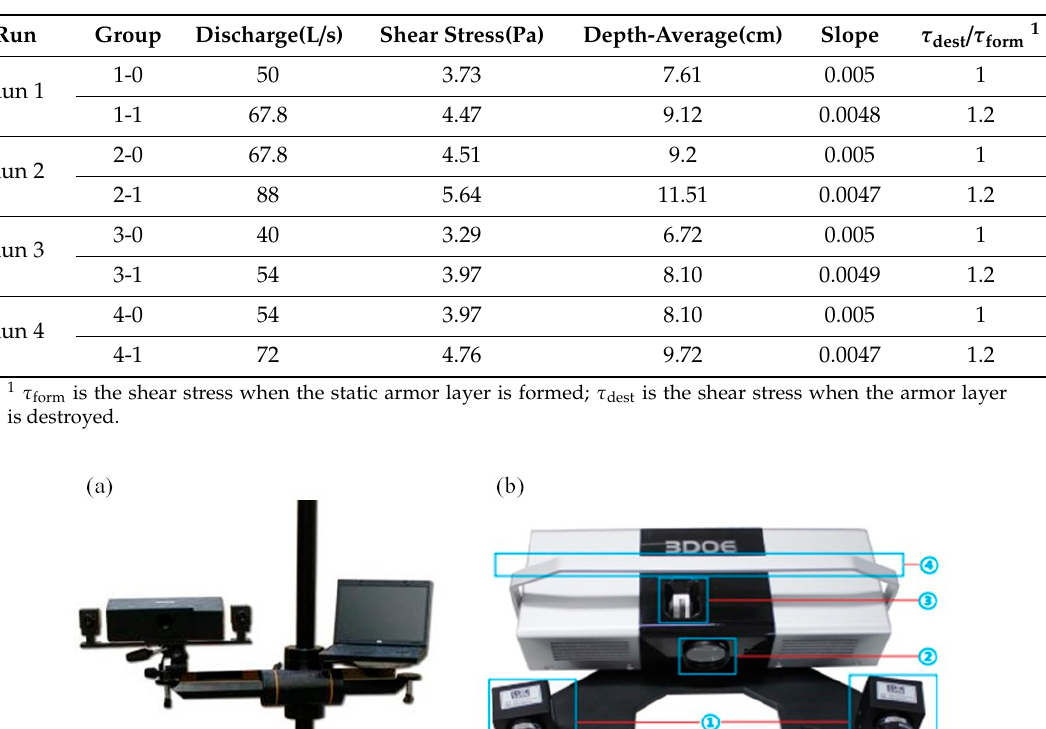
Table 1. Hydraulic condition for each set of laboratory flume experiments.